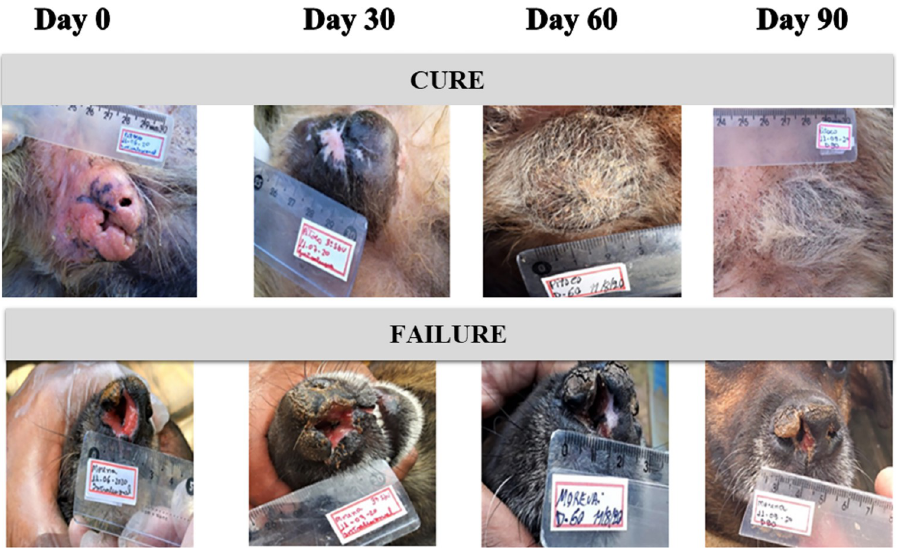
Fig 1. Pictures of two animals on days zero, 30, 60, and 90; “the first, A,” from a dog scrotal sac ulcer treated with Glucantime and “B” from a dog with a muzzle lesion treated with saline. While the dog receiving Glucantime was cured on day 30, the cutaneous lesion remained active until day 90 in the animal treated with placebo.